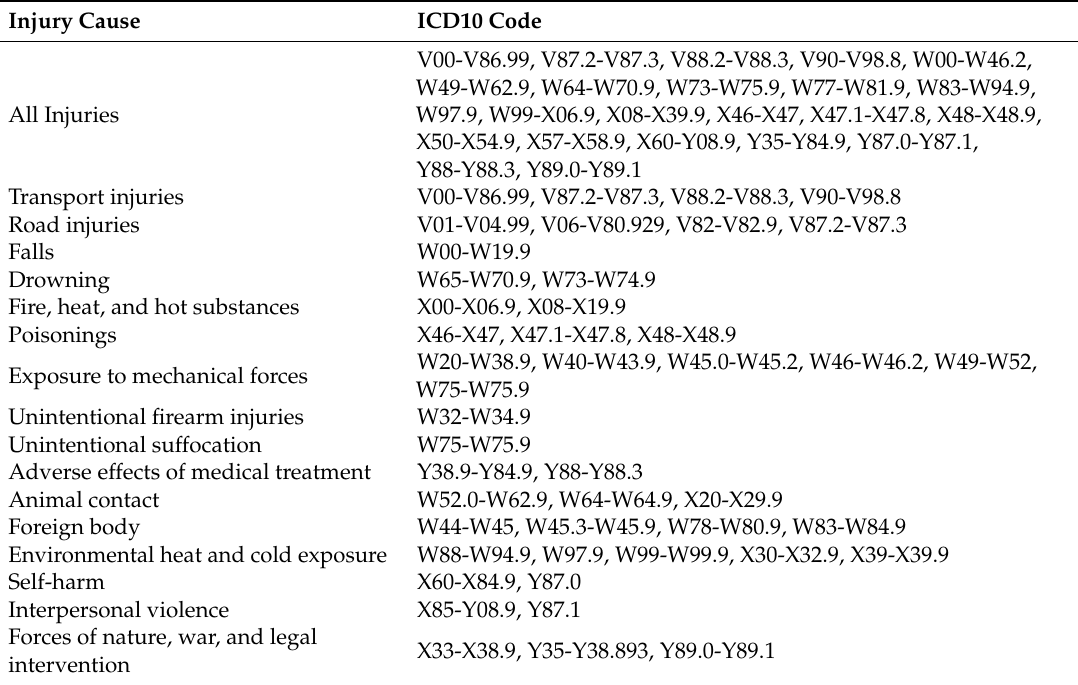
Table 1. Injury causes and associated codes from the 10th International Classification of Diseases (ICD-10) included in the GBD 2015